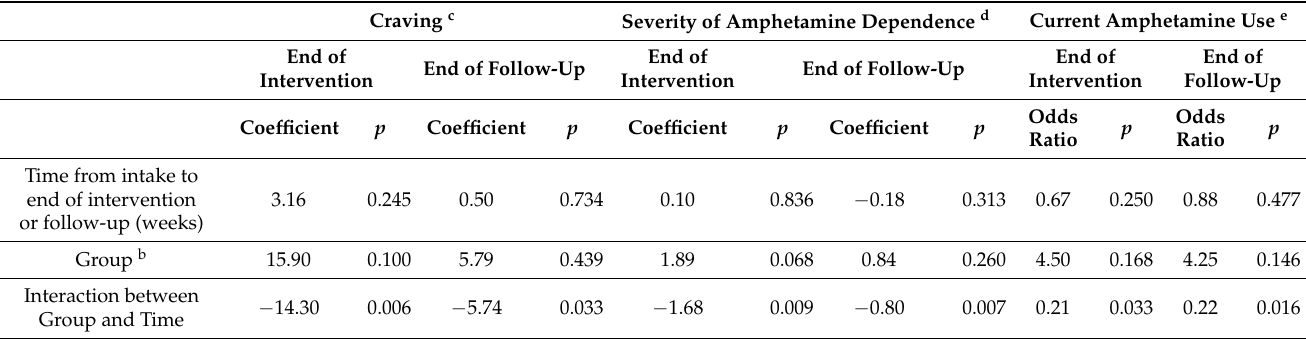
Table 3. Effect of HRVBFB intervention on level of craving, severity of amphetamine dependence, and amphetamine use after the intervention and at the end of follow-up a